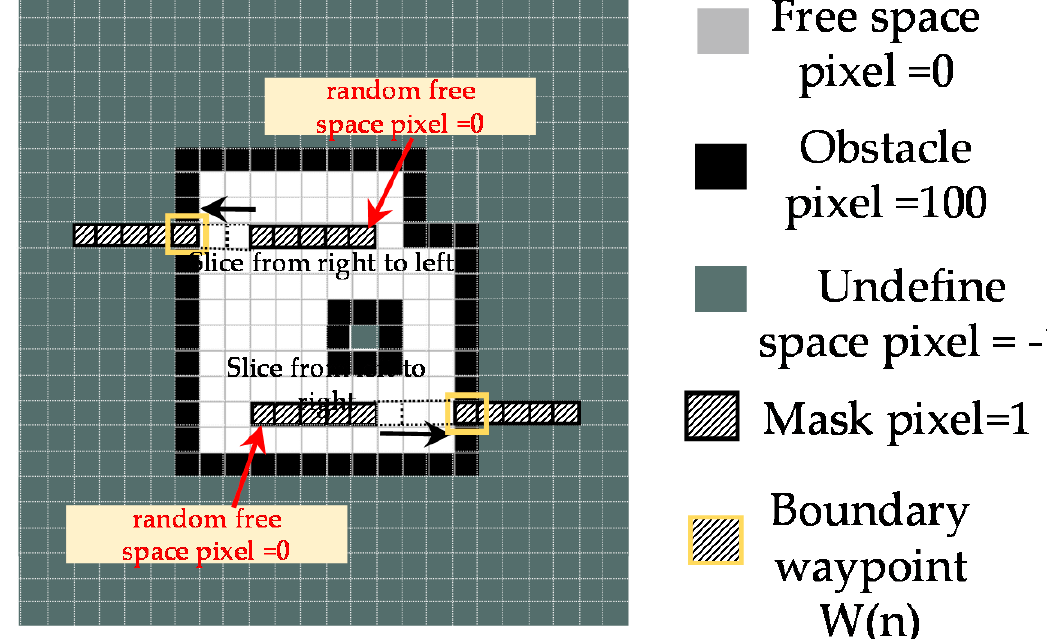
Figure 11. Left and right boundary waypoints estimating.